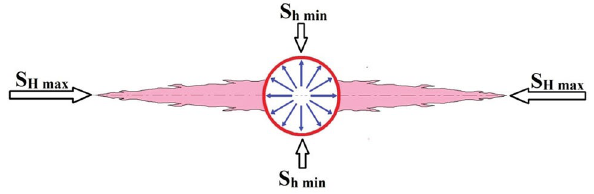
Fig. 3 Creating a perpendicular fracture for minimum